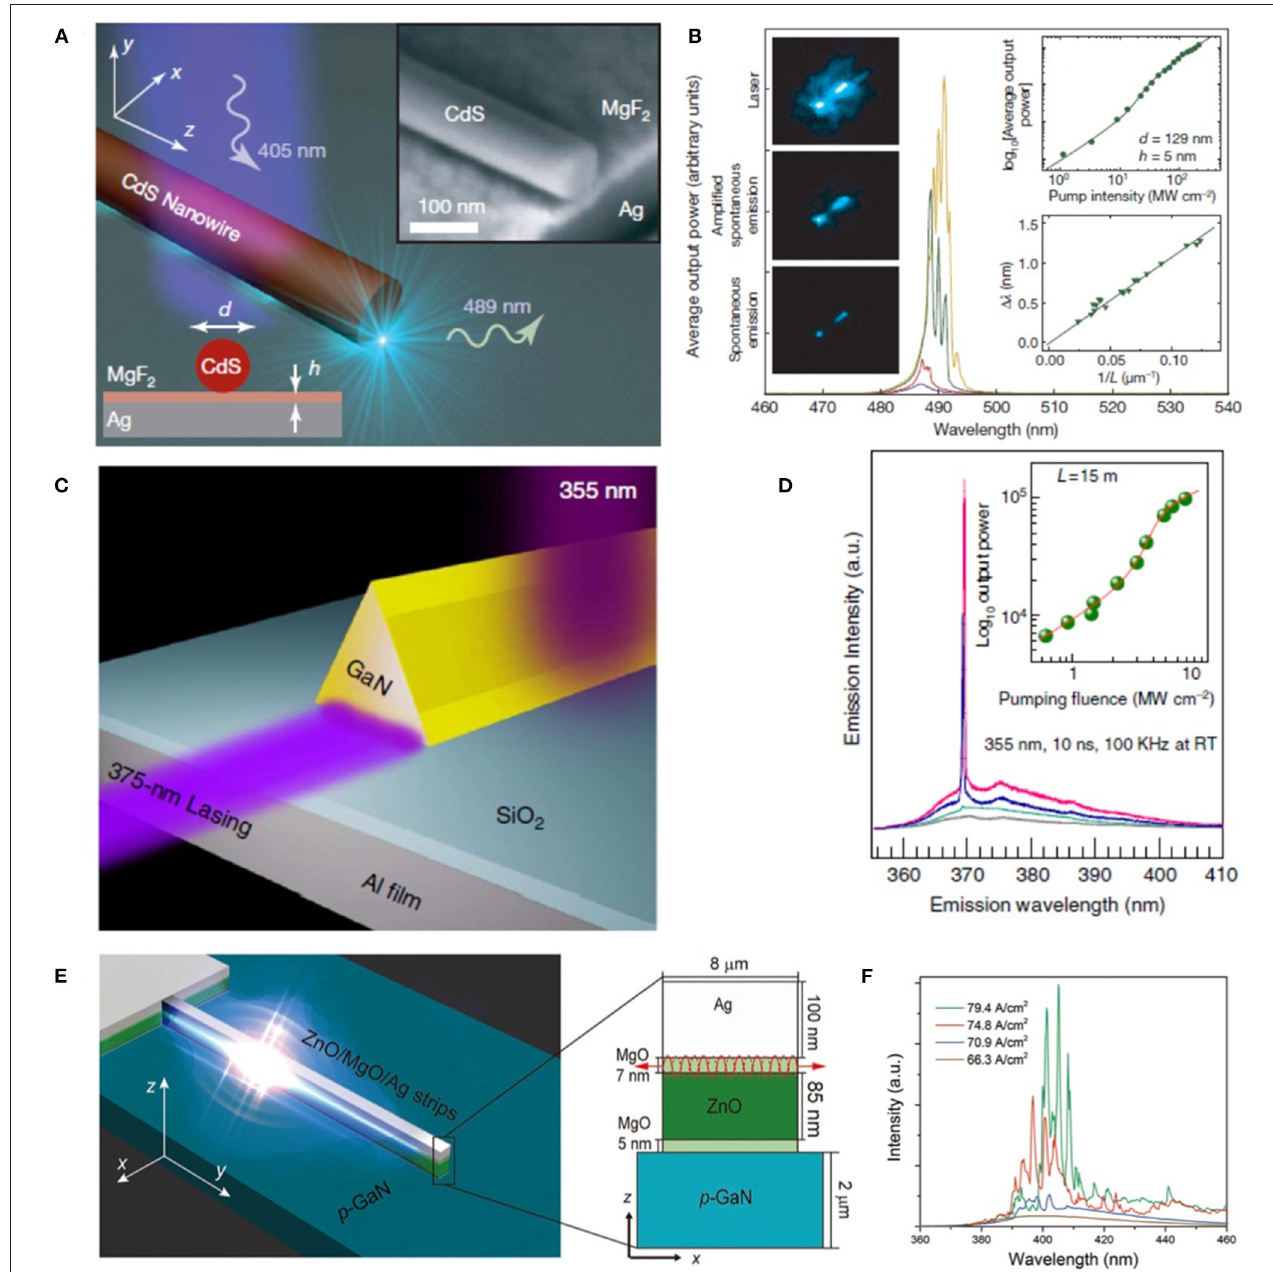
FIGURE 5 | (A) The plasmonic laser consists of a CdS semiconductor nanowire on top of a silver substrate, separated by a nanometer-scale MgF 2 layer of thickness h . Inset: SEM image of the structure. Scale bar: 100nm. (B) Laser oscillation of a plasmonic laser. The four spectra for different peak pump intensities show the transition from spontaneous emission (21.25 MW cm − 2 ) via amplified spontaneous emission (32.50 MW cm − 2 ) to full laser oscillation (76.25 and 131.25 MW cm − 2 ). Left inset: optical images at different pumping intensities. Upper right inset: The non-linear response of the output power to the peak pump intensity. Lower right inset: The relationship between mode spacing 1 λ and nanowire length L . (C) Schematic of GaN plasmonic devices. (D) Power-dependent emission spectra of the plasmonic devices. Inset shows the light-light curve. (E) The schematic diagram of the p-GaN/MgO/ZnO/MgO/Ag structure. Inset illustrates the SPPs feedback diagram in the ZnO/MgO/Ag cavity. (F) Injection current density dependent emission spectra of the plasmonic laser. (A,B) Reproduced with permission. Oulton et al. (2009) Copyright 2009, Nature Publishing Group. (C,D) Reproduced with permission. Zhang et al. (2014b) Copyright 2014, Nature Publishing Group. (E,F) Reproduced with permission. Yang X. et al. (2019) Copyright 2018,